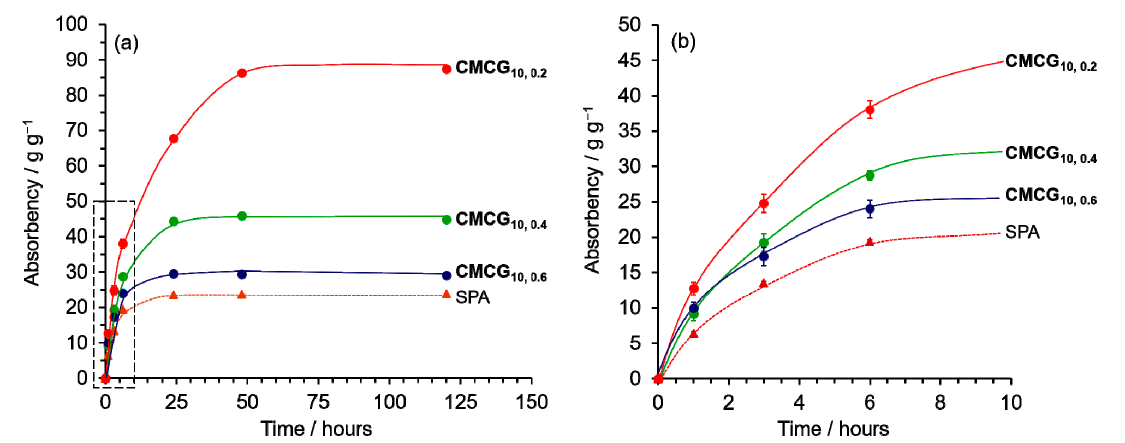
Figure 5. Time-dependence of the absorbency of the CMCGs and SPA ( a ) toward PBS and ( b ) initial stage of the absorbency.